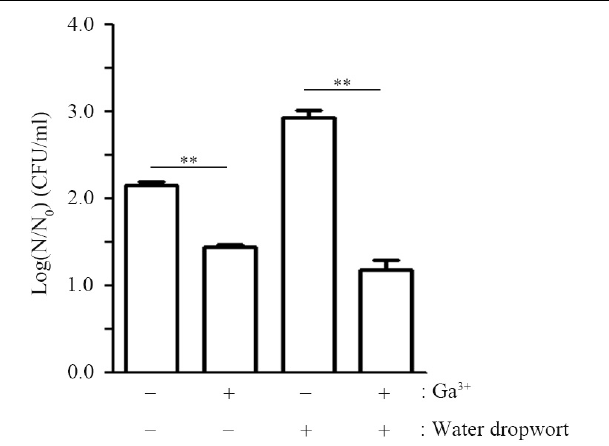
FIGURE 4 | Effect of gallium nitrate on the growth of FORC_035. Wild-type FORC_035 was cultivated in M9 minimal medium broth with or without water dropwort and Ga(NO 3 ) 3 was added to the medium at 1 mM. Bacterial numbers were estimated at 9 h post-inoculation. Note that log( N / N 0 ) is plotted on y -axis, where N 0 is the initial number of cells at 0 h and N is the number of cells after a 9-h incubation. Asterisks indicate significant differences ( ∗∗ P < 0.01).